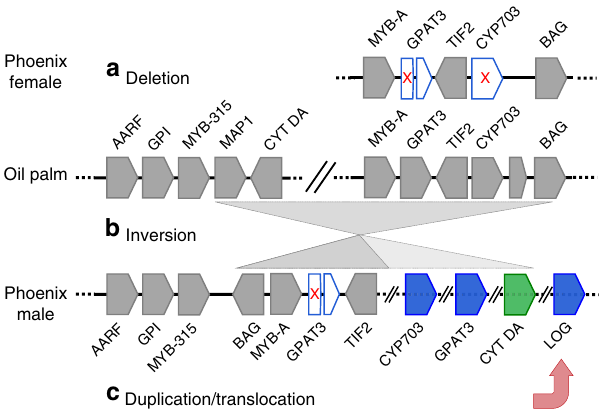
Fig. 4 A model for the development of dioecy in the genus Phoenix . The genes in the region as found in female scaffold dpS2X, oil palm scaffold NW_011550905.1, and male contig dpB2Y. The fact that the male-speci fi c sequences are focused in this region suggests that it may be the origin of sex determination in Phoenix . a The fi rst step would be the deletion (white pentagons with red x) of GPAT3 and/or CYP703 , two genes known to be proto-X chromosome. b An inversion (gray triangles) of the corresponding region on the normal chromosome moving the cytidine deaminase (CYT DA) gene would create a proto-Y chromosome with recombination arrest.